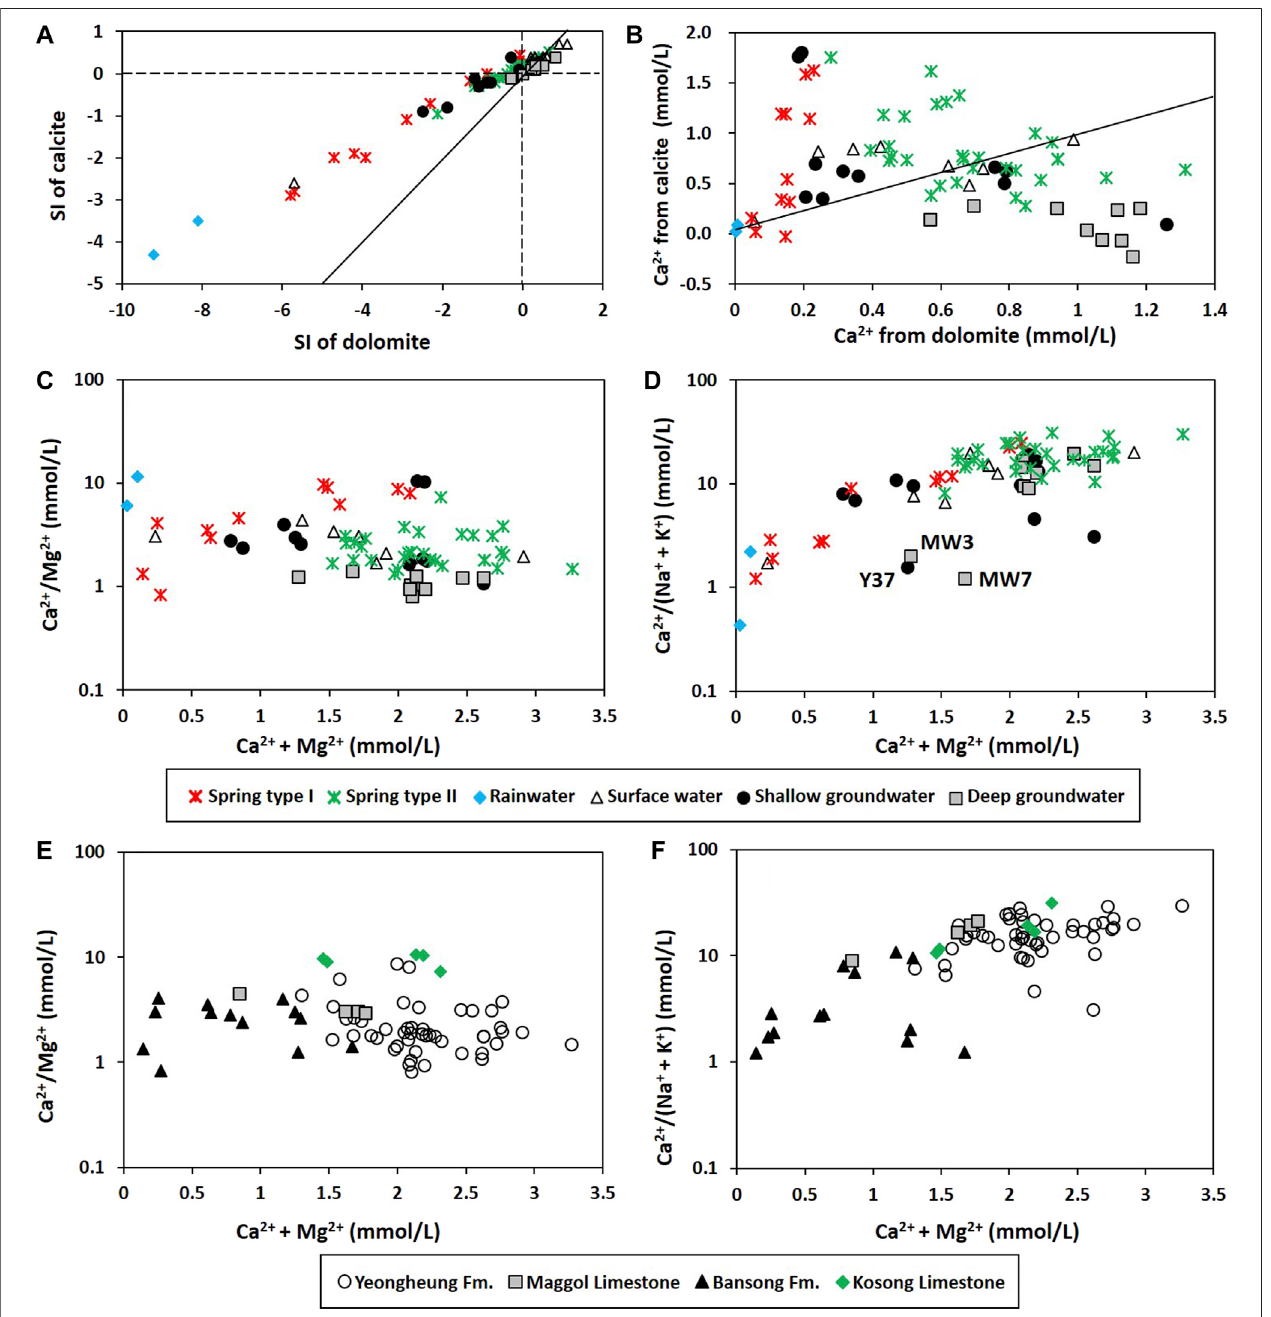
FIGURE 6 | Degrees of water-rock interactions: (A) Saturation index (SI) of calcite and dolomite; (B) Ca 2+ derived from dolomite (estimated using mMg) vs. Ca 2+ derivedfromcalcite(estimatedusingmCa — mMg)followingLacelleetal.(2008).In (A) and (B) ,theslopeofthesolidlineisone. (C) Ca 2+ /Mg 2+ vs.Ca 2+ +Mg 2+ ; (D) Ca 2+ / (Na + + K + ) vs. Ca 2+ + Mg 2+ depending on the water group; (E) Ca 2+ /Mg 2+ vs. Ca 2+ + Mg 2+ ; (F) Ca 2+ /(Na + + K + ) vs. Ca 2+ + Mg 2+ depending on the lithology around the sampling location. Rainwater was excluded in (E) and (F) . In (D) , the letters indicate the names of distinct samples.